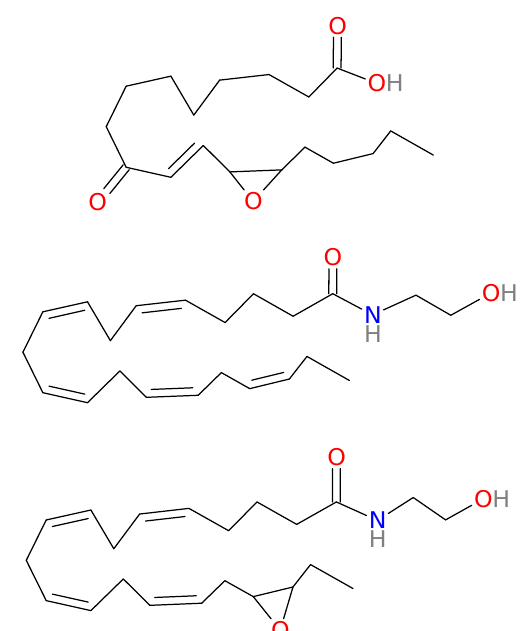
Figure 1. From top to bottom are shown the chemical structures of EKODE, EPEA, and 17,18-EEQ- EA.